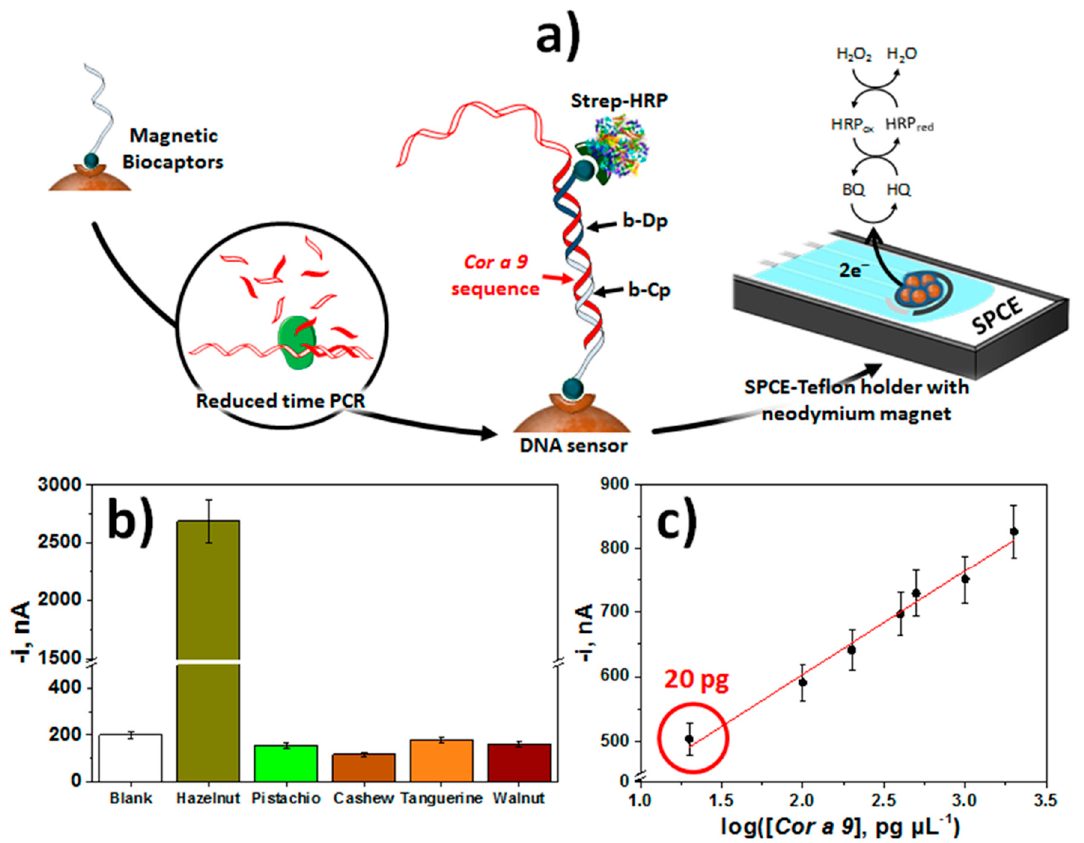
Figure 5. ( a ) Schematic display of the fundamentals involved in the construction of an electrochemical bioplatform using MBs for the detection of Express PCR amplified fragments specific to the hazelnut Cor a 9 allergen coding sequence. ( b ) Amperometric responses provided by the developed bioplatform for 50-times diluted Express PCR amplicons obtained with gDNA extracted from hazelnut, pistachio, cashew, tangerine and walnut. ( c ) Dependence of the amperometric responses provided by the developed bioplatform for 50-times diluted Express PCR amplicons obtained using di ff erent amounts of hazelnut gDNA. Reprinted and adapted from [36], with